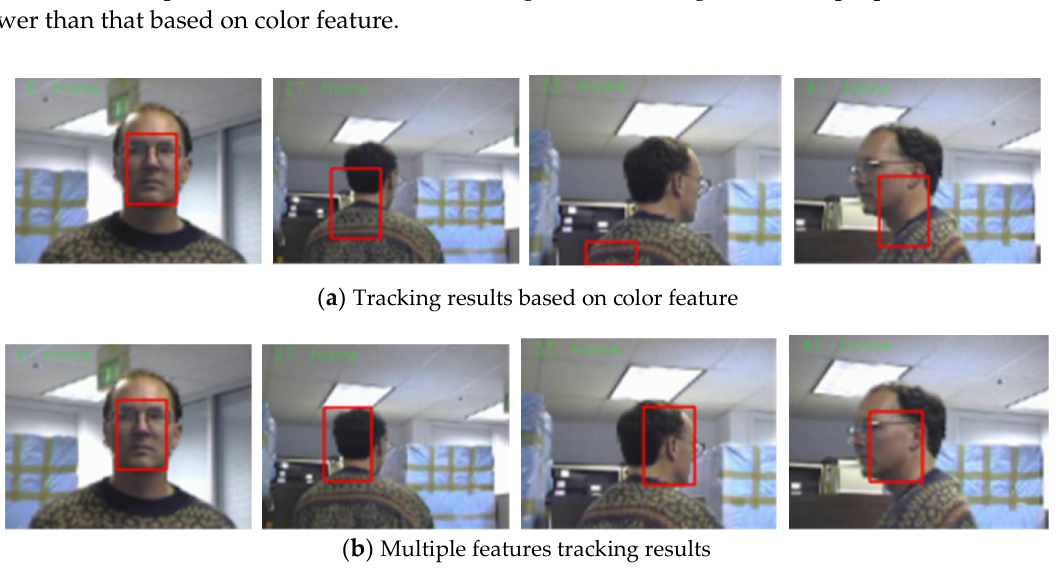
Figure 9. The RMSE comparison corresponding to background change.